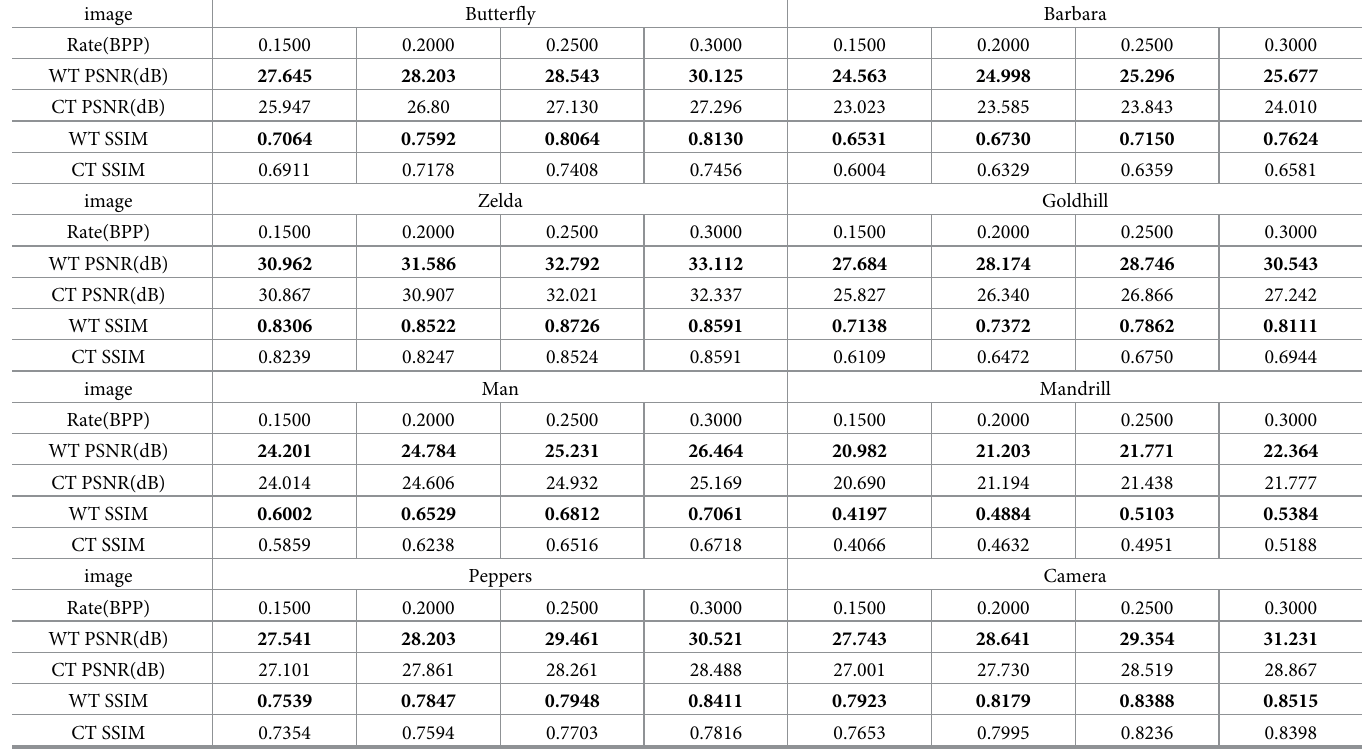
Table 1. Image compression performance of